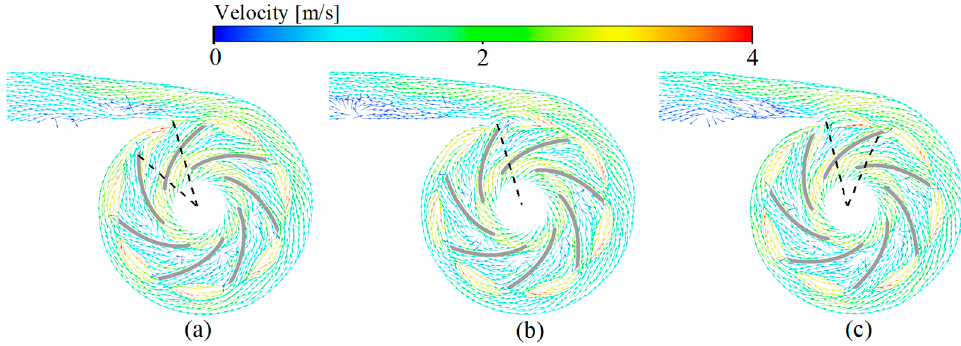
Figure 4. Rotor position independent verification of the CH-VAD: ( a ) Base position − 20°; ( b ) Base position; and ( c ) Base position +20°.